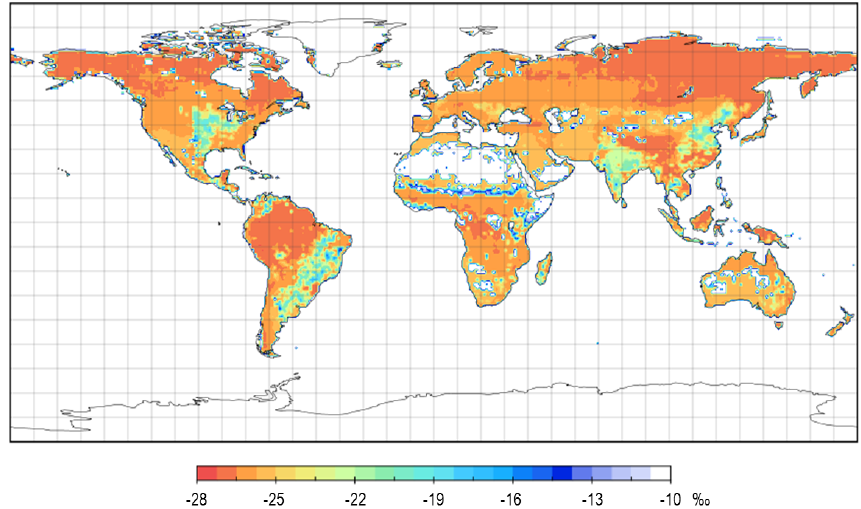
Figure 5. Global δ 13 C distribution over land (annual flux-weighted average in